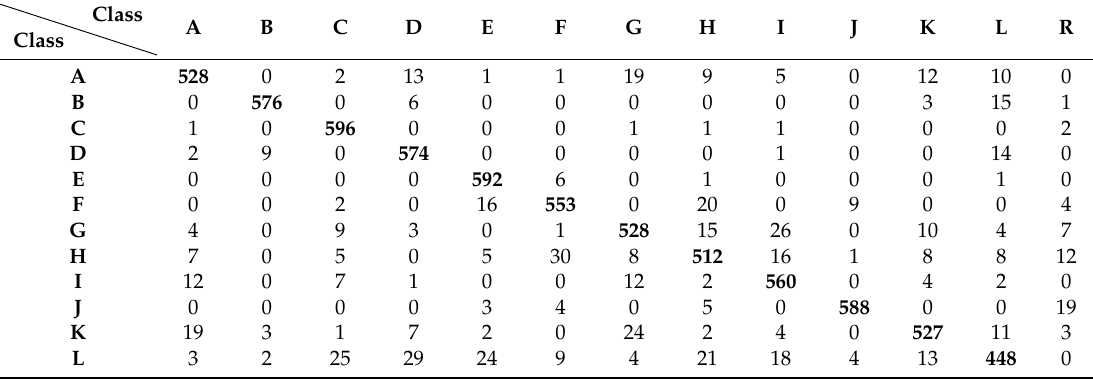
Table 2. Classification results for MLG feature set with MLP